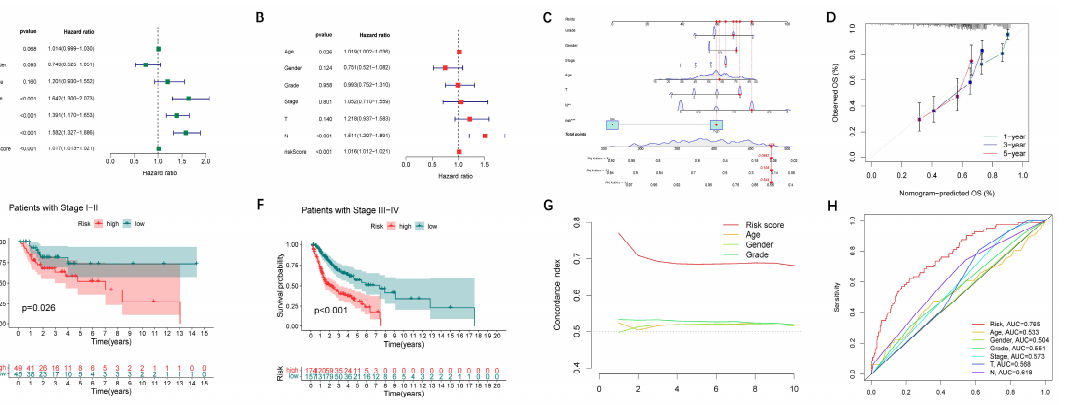
Figure 6. ( A ) The lncRNAs–mRNA co-expression network of HNSCC. ( B ) The Sankey diagram shows the relationship between the oxidative lipid metabolism-related mRNAs and the 24 lncRNAs. ( C ) The top 10 pathways significantly enriched in the high-risk group of the GSEA analysis. ( D ) The top 10 pathways significantly enriched in the low-risk group of the GSEA analysis. The results of the univariate and multivariate Cox regression indicated that age, lymph node metastasis (N), and risk score are independent risk factors (HR > 1, p < 0.05) (Figure 7A,B). The nomogram was based on the risk score, age, gender, grade, tumor size (T), lymph node metastasis (N), and tumor stage, as is shown in Figure 7C. In addition, we performed 1-, 3-, and 5-year calibration plots to demonstrate that the nomogram accu- rately predicted the 1-, 3-, and 5-year OS (Figure 7D). To test the usefulness of the nomo- gram, we also conducted tumor-stage-based subgroup analyses (stage I-II vs. stage III-IV; Figure 7E,F). The results of the C-index and ROC analysis indicated that the risk score can predict the patient prognosis more precisely (Figure 7G,H).